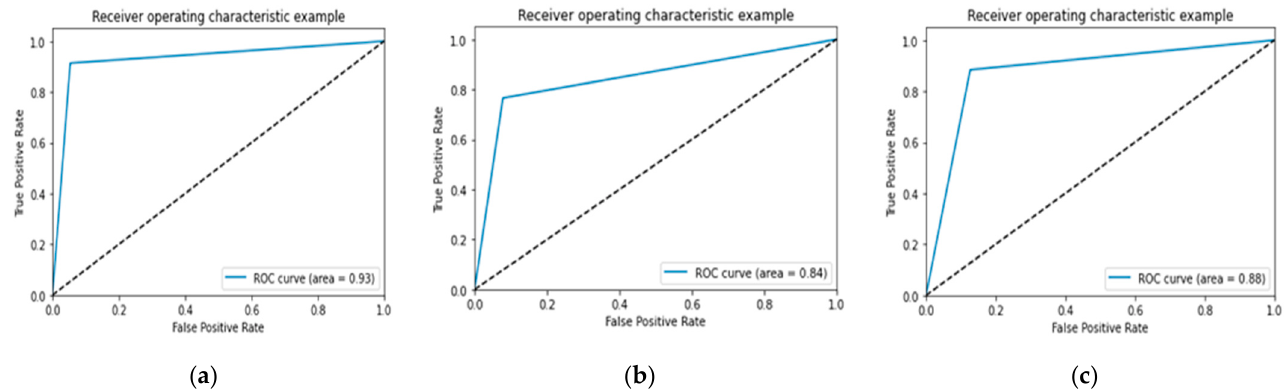
Figure 9. Plots demonstrating the DenseNet-121 for comparing reasons, for the CAD classification problem: ( a ) accuracy; ( b ) loss.